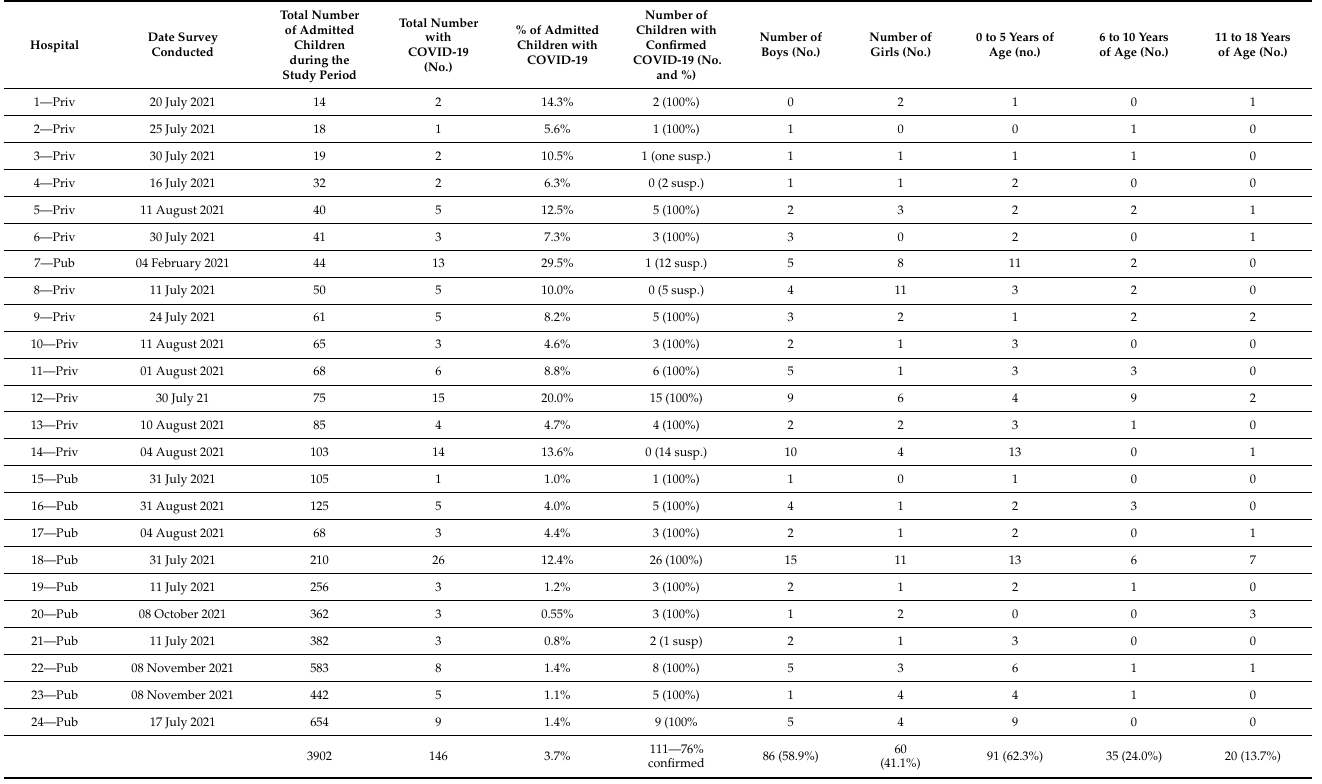
Table 2. Patient characteristics among the 24 participating hospitals during the study period.